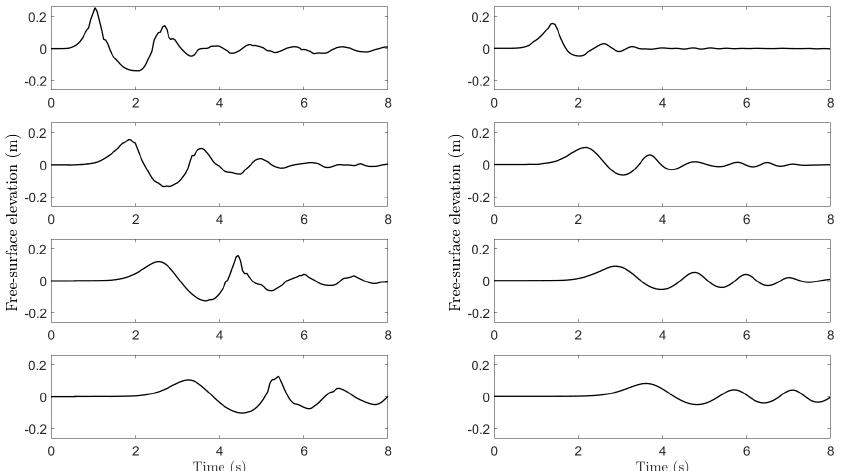
Figure 10. Evolution of wave profiles: records of free-surface elevation at select locations (Top to bottom: x = 1,3,5,7 m). Left : results for Case 00 ( σ = 0). Right : Case 07 ( σ = 0.7